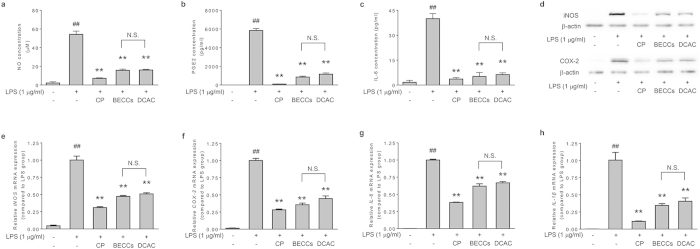
Anti-inflammatory effect validation of DCAC in LPS-stimulated RAW264.7 macrophages.Cells were pretreated with tested samples (at a corresponding concentration in 0.4 mg/ml CP) for 1 h, followed by treatment with LPS (1 μg/ml) and incubation for indicated time. Concentration of (a) NO, (b) PGE2 and (c) IL-6 in the supernatant. (d) Protein expression levels of iNOS and COX-2. β-actin was used as an internal loading control. The expression levels of mRNA for (e) iNOS, (f) COX-2, (g) IL-6 and (h) IL-1β were analyzed by quantitative real-time PCR. GAPDH served as internal control for normalization of mRNA expression. Data are presented as mean ± SD of three independent experiments performed in duplicate. ##p < 0.01 versus control group; *p < 0.05, **p < 0.01 versus LPS group (one-way ANOVA, Dunnett test). CP: Cardiotonic Pill; BECCs: bioactive equivalent combinatorial components; DCAC: dominant combination of anti-inflammatory compounds.